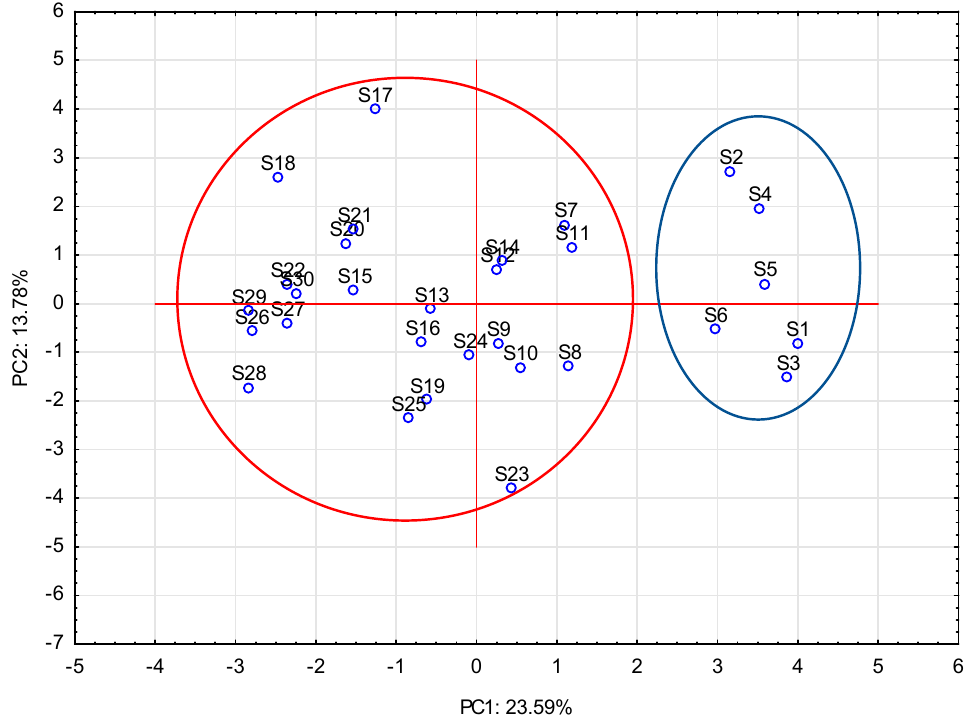
Figure 2. Projection of samples on a surface for the first two principal components (PC).